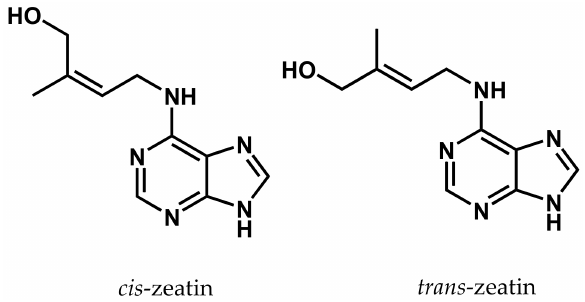
Figure 3. The structures of cis -zeatin and trans